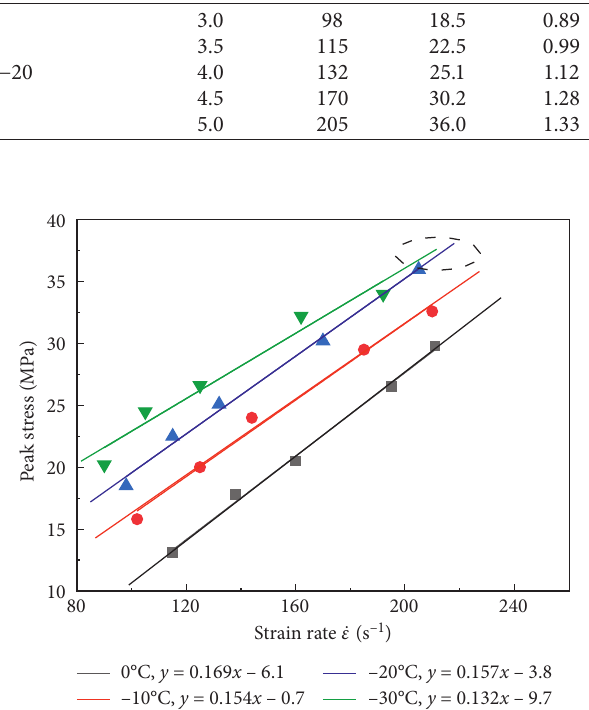
Figure 3: Relationship between peak stress and strain rate.